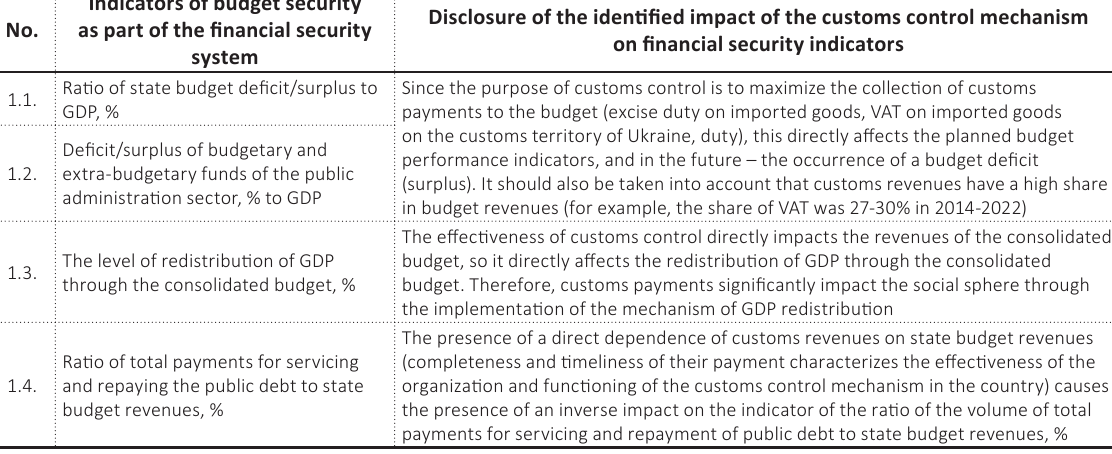
Table 2. Indicators of budget security in the financial security system and the impact customs control has on them